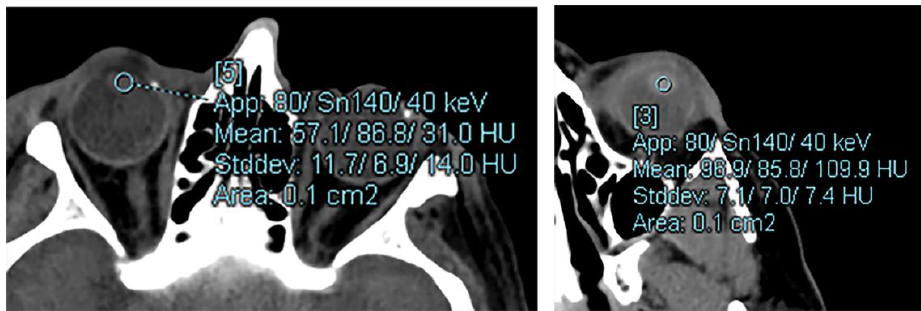
Figure 1. A representative example of how ROI measurements were obtained for the study. All measurements were obtained in the axial plane using 1 mm thick slices. ROI data was obtained using the default syngo.via Monoenergetic+ application. All scans were non-contrast dual-source, dual-energy CT exams. See the text Section 2.2. for the DECT acquisition parameters.